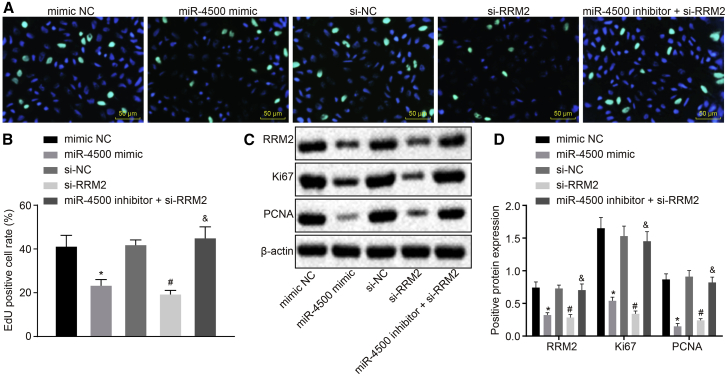
Overexpression of miR-4500 Represses the Expression of RRM2 to Inhibit Breast Cancer Cell Proliferation(A) The cell proliferation detected by the EdU proliferation assay (400×). (B) Quantitative analysis for EdU-positive breast cancer cells detected by the EdU proliferation assay. (C) The protein expressions of RRM2 and cell proliferation-related factors Ki67 and PCNA detected by Western blot. (D) Comparison of relative protein expressions of RRM2 and cell proliferation-related factors Ki67 and PCNA in each group.. The data comparisons were analyzed by one-way ANOVA, and the experiment was repeated three times independently.